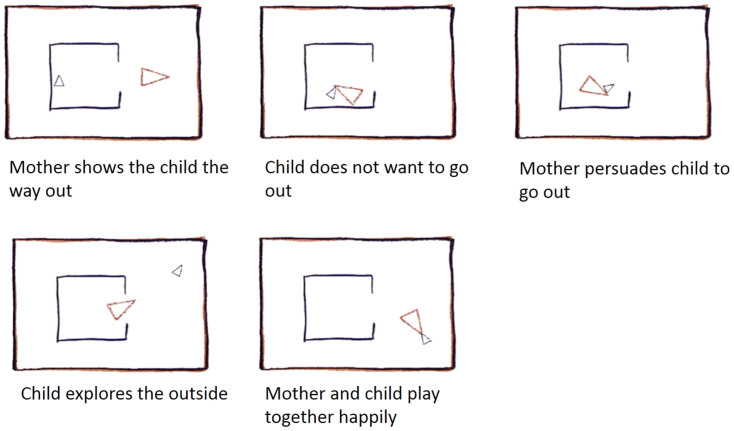
Example of “Theory of Mind” animation: The Big Triangle coaxing the reluctant Little Triangle to come out of an enclosure (participants do not see captions; stimuli and description adapted from13.)